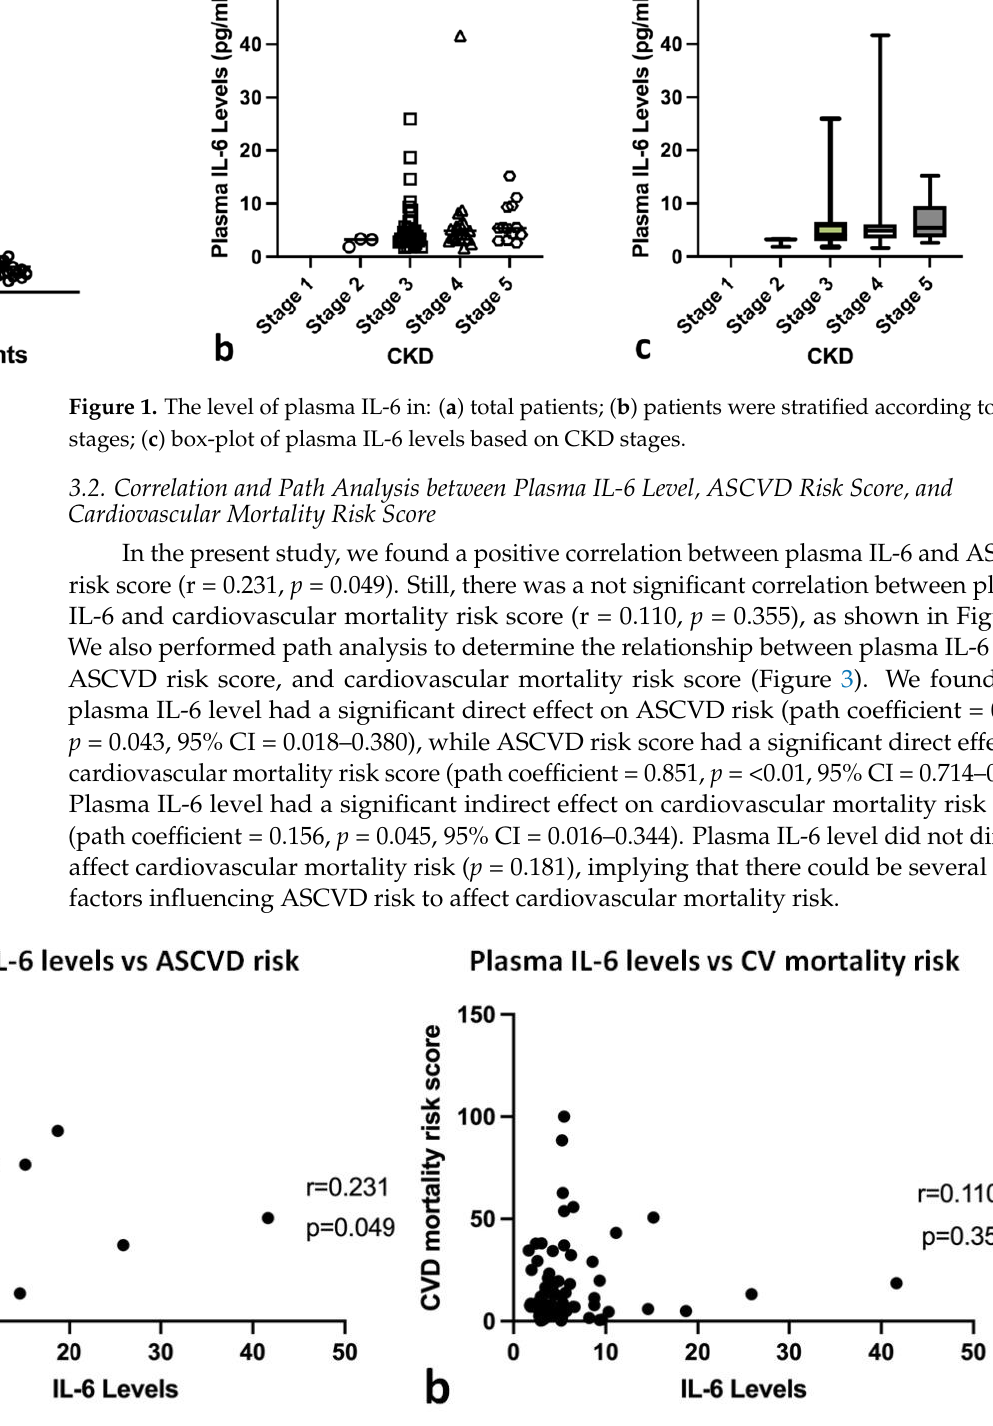
Figure 2. XY correlation plot between plasma IL-6 and ASCVD and CV mortality risk scores: ( a ) XY correlation plot between plasma IL-6 and ASCVD risk score; ( b ) XY correlation plot between plasma IL-6 and CV mortality risk score. Plasma IL-6 levels were measured at pg/mL unit.